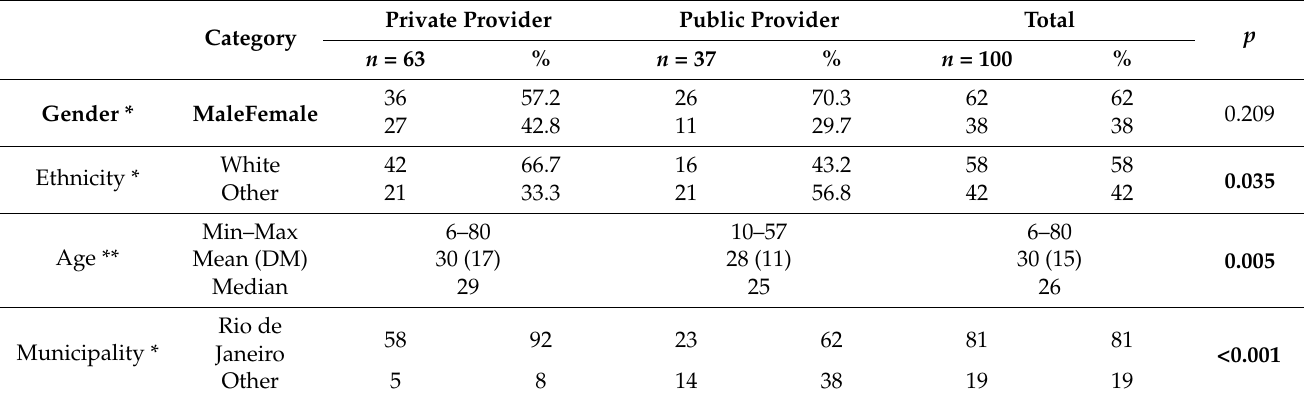
Table 1. Characteristics and demographics of study